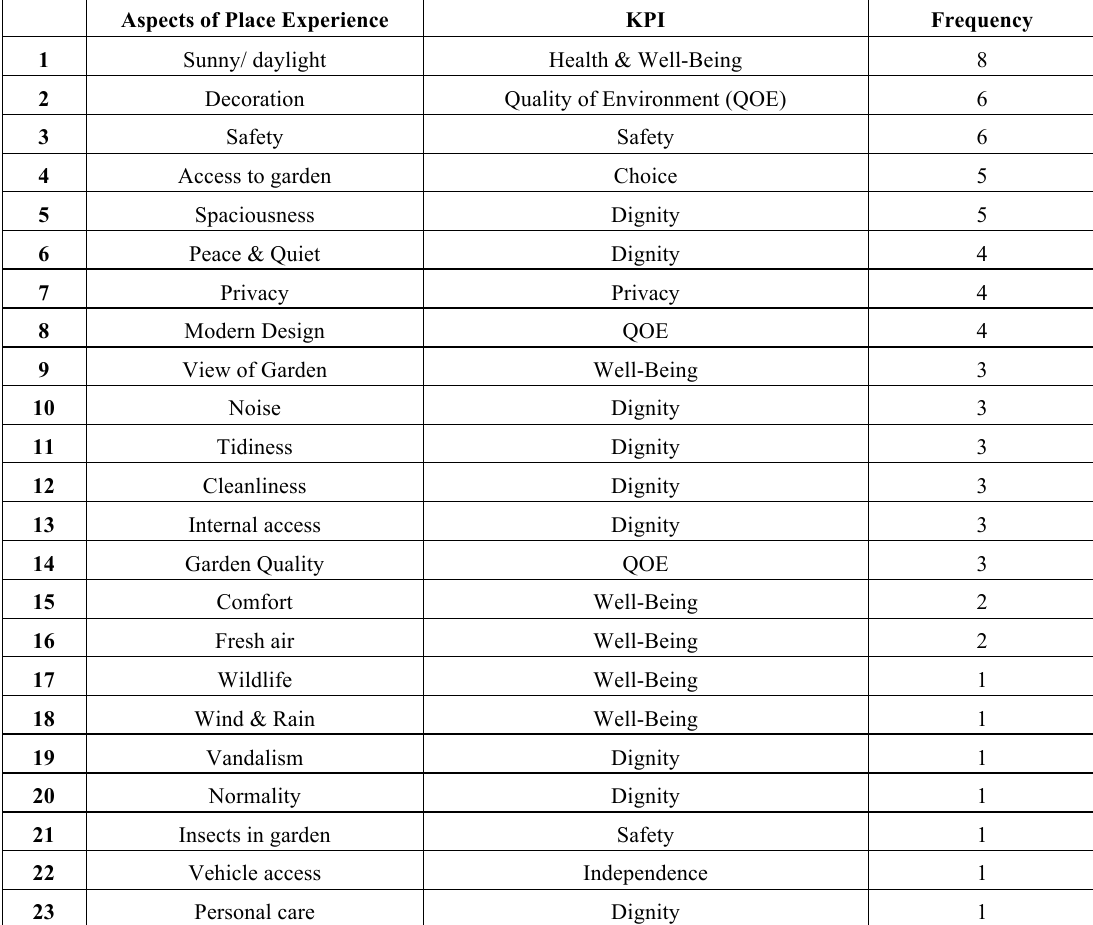
Table 4. Questionnaire responses related to aspects of place experience ranked by